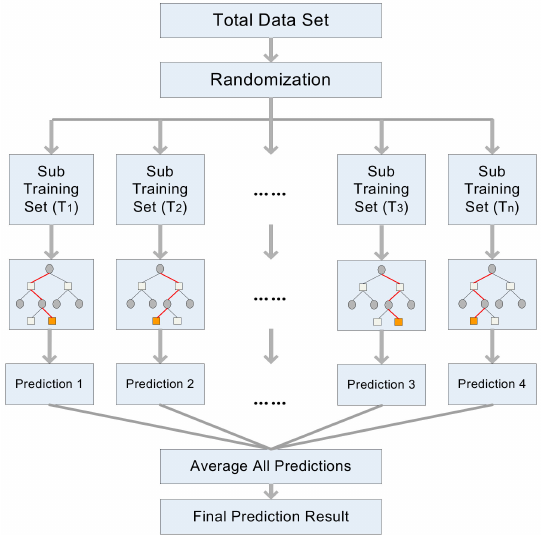
Figure 8. Conceptual diagram of random forest (RF)